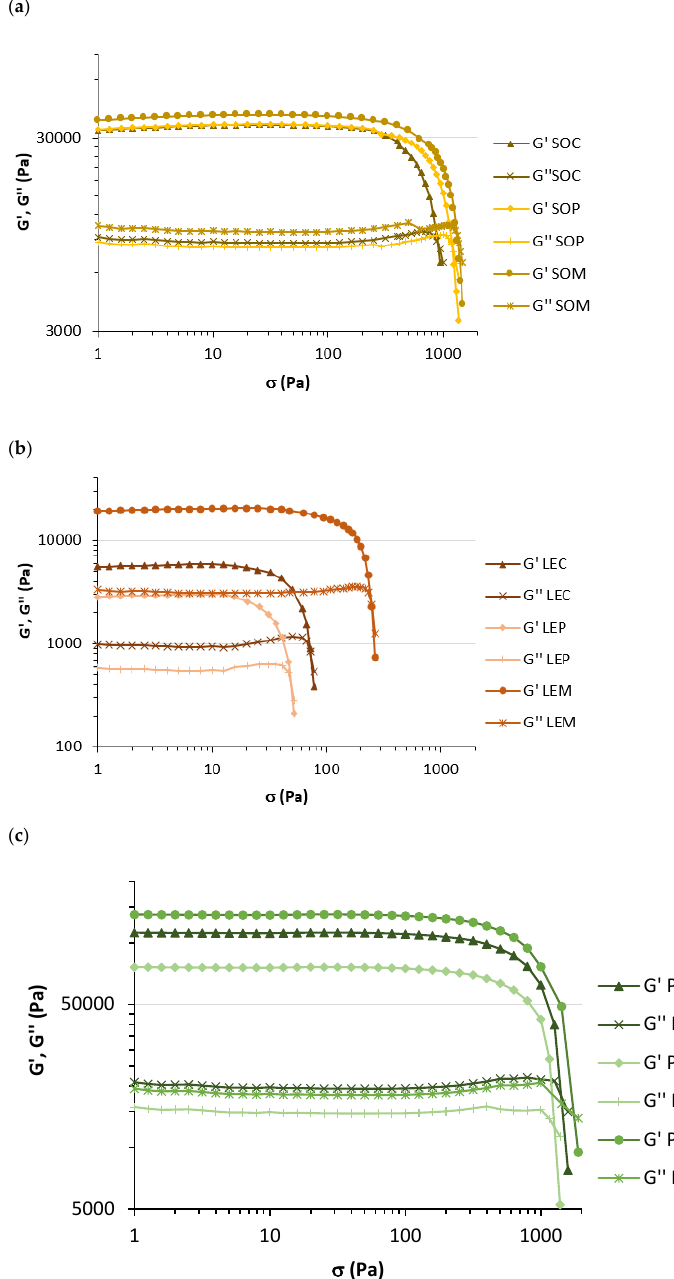
Figure 1. Changes in elastic modulus (G’) and viscous modulus (G”) according to stress for legume pastes from ( a ) soybean, ( b ) lentil, and ( c ) pea subjected to different cooking methods (SOC, ordinary cooked soybean; SOP, pressure-cooked soybean; SOM, microwave-cooked soybean; LEC, ordinary cooked lentil; LEP, pressure-cooked lentil; LEM, microwave-cooked lentil; PEC, ordinary cooked pea; PEP, pressure-cooked pea; PEM, microwave-cooked pea).